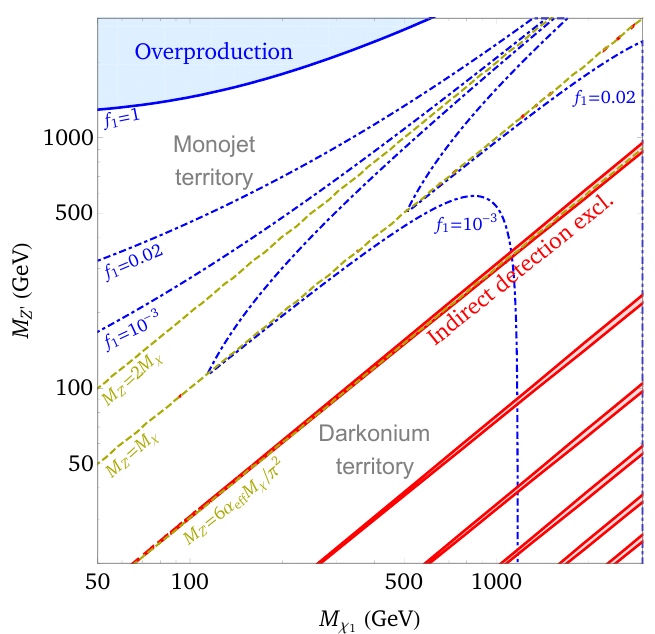
Figure 8 . Cosmological constraints in the same model parameter space as (cid:12)gure 1 with the same choice of parameters. Assuming a thermal history of the dark matter (cid:31) 1 , it could obtain the correct thermal relic density along the blue solid curve. The blue shaded region is because of the overproduction of (cid:31) 1 ’s relic density. Outside the blue region, (cid:31) 1 is underproduced and could only account for a fraction of the total dark matter (shown by blue dot-dashed contours). The red spiky regions are ruled out by indirect detection experiments due to the Sommerfeld enhancement, in spite of the small relic density. All the white regions in this plot are still alive. Here, f 1 is the fraction of observed dark matter relic density that is comprised of our dark matter candidate (cid:31) 1